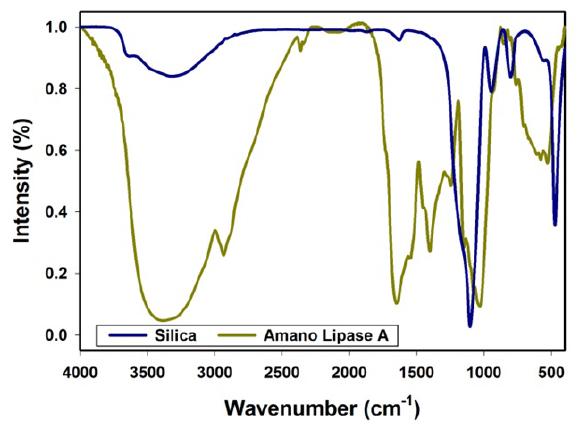
Figure 2: FT-IR spectra of silica and Amano Lipase A .